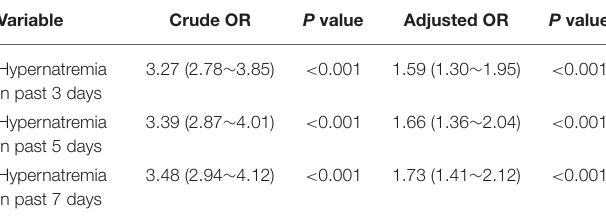
TABLE 4 | Sensitivity analysis for the duration of hypernatremia exposure on delirium. Variable Crude